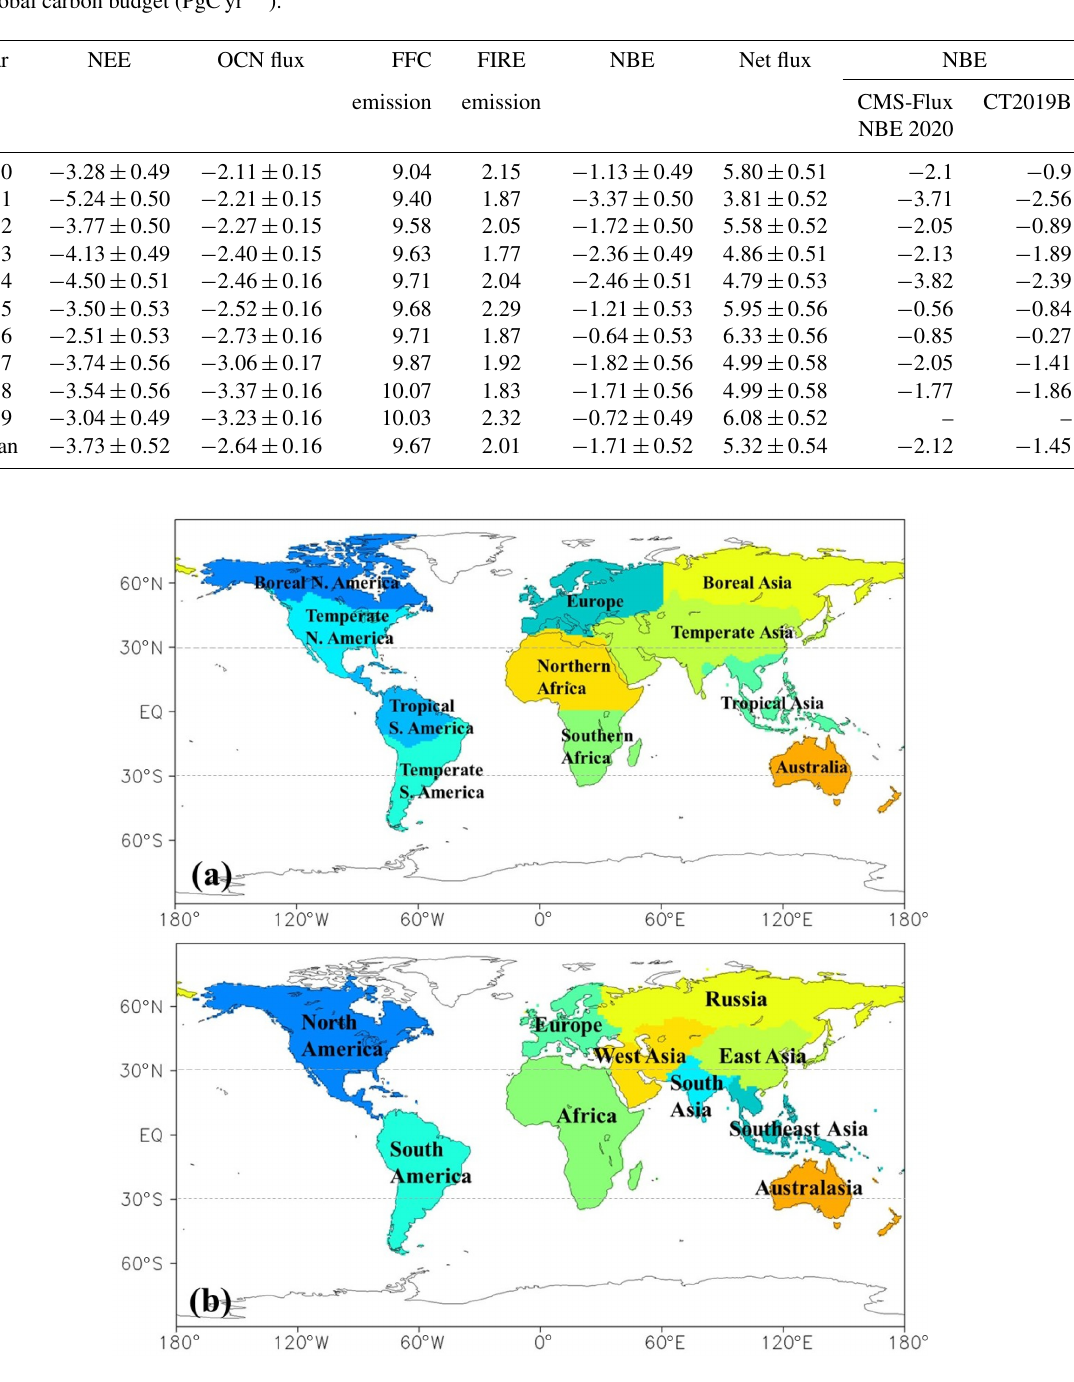
higher than that in 2015 and significantly higher than the ob- served value, which is mainly due to the abnormally low car- bon sink in the tropical latitudes (TL, 30 ◦ S–30 ◦ N) in this year (Fig. 7). The reason may be related to the biases in the GOSAT XCO 2 retrievals in TL. We analyze the monthly